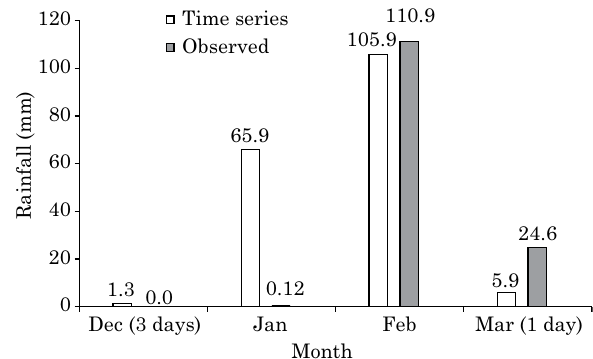
Figure 2. rainfall from a time series and from the data observed in the experimental